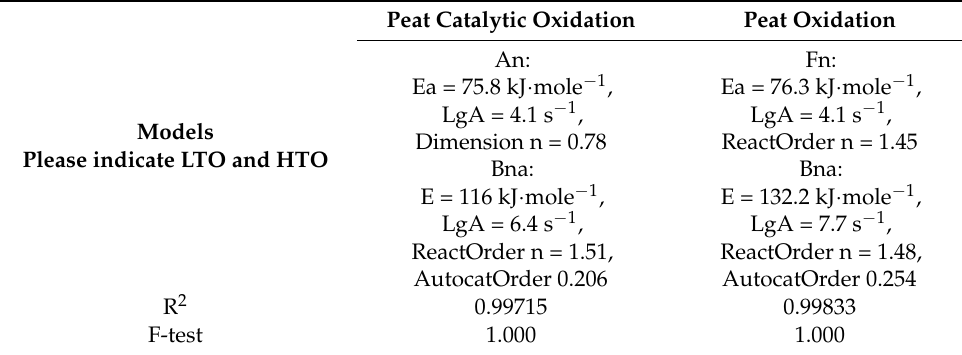
Table 4. Kinetic parameters of peat model oxidation